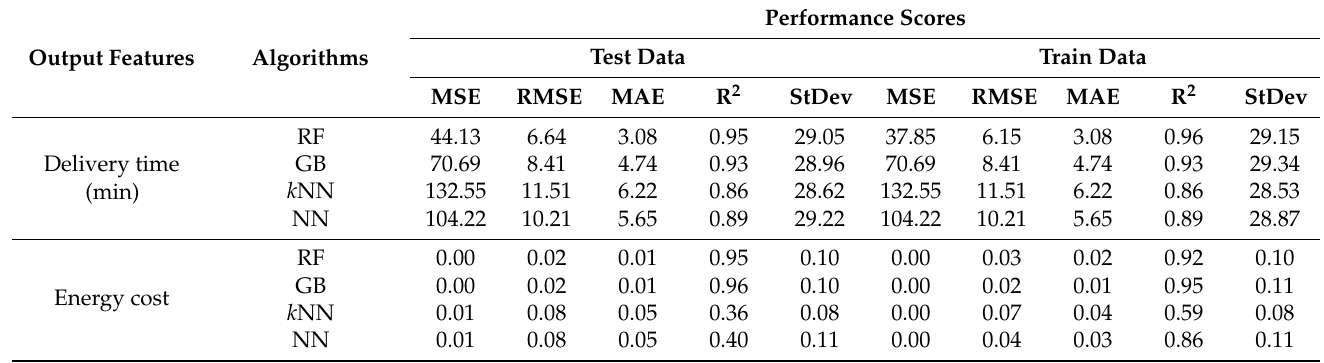
Table 6. The comparison of performance evaluation metrics results based on the train and test